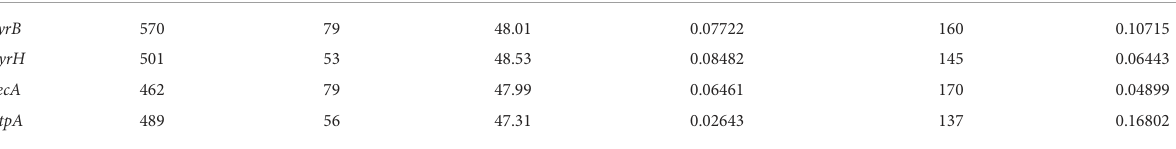
The ratio of nonsynonymous to synonymous substitutions (d N /d S